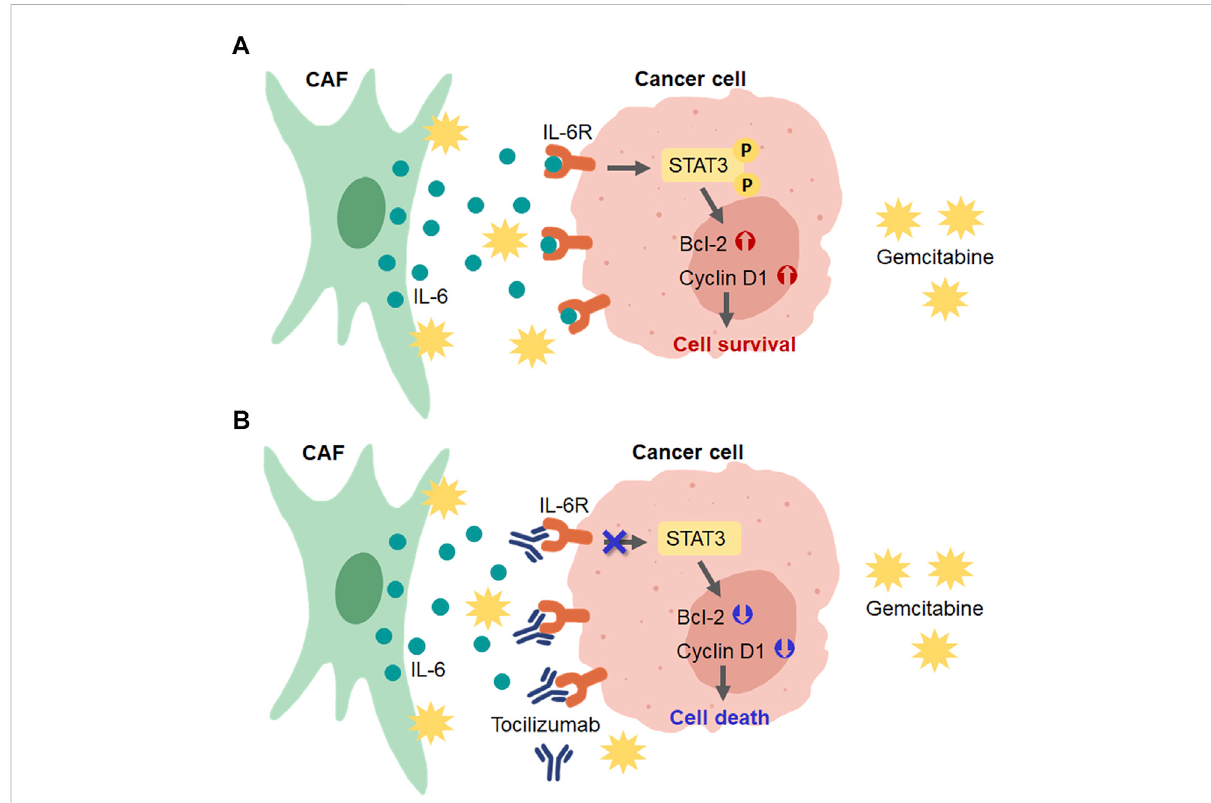
FIGURE 8 Schematic diagram for the role of CAFs in CCA cell resistance to gemcitabine and the presence of IL-6R blockage by tocilizumab. (A) CAFs secreted IL-6 to induce IL-6R/STAT3 signaling and upregulated the expression of proteins involved in the cell survival mechanism in CCA cells. (B) Blocking the IL-6-IL-6R binding in CCA cells by tocilizumab inhibited CAF-CCA interaction overcame the gemcitabine resistance and induced CCA cell